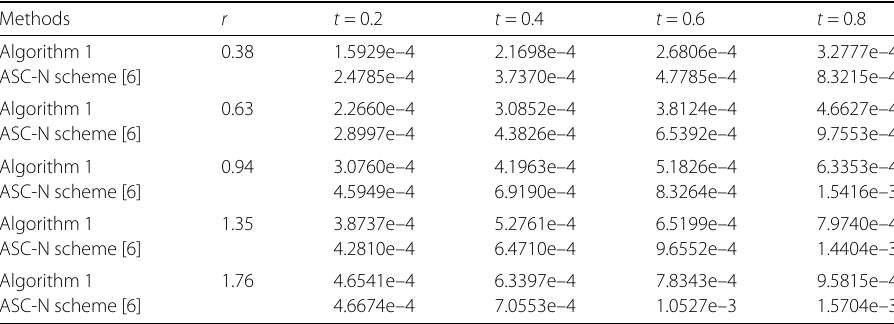
Table 5 Comparisons by the maximum errors to Example 1 for h = 1/25 (i.e., m – 1 = 24 = 6 K , K = 4)